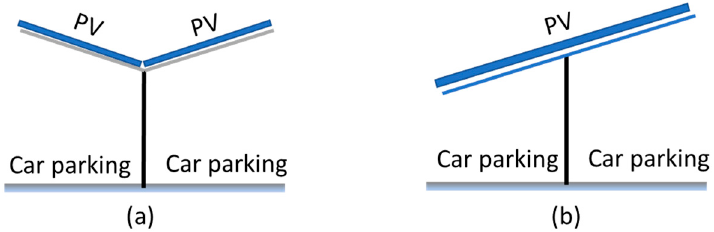
Figure 1. Types of car park roof structures ( a ) duo-pitch canopy and ( b ) mono-pitch canopy.